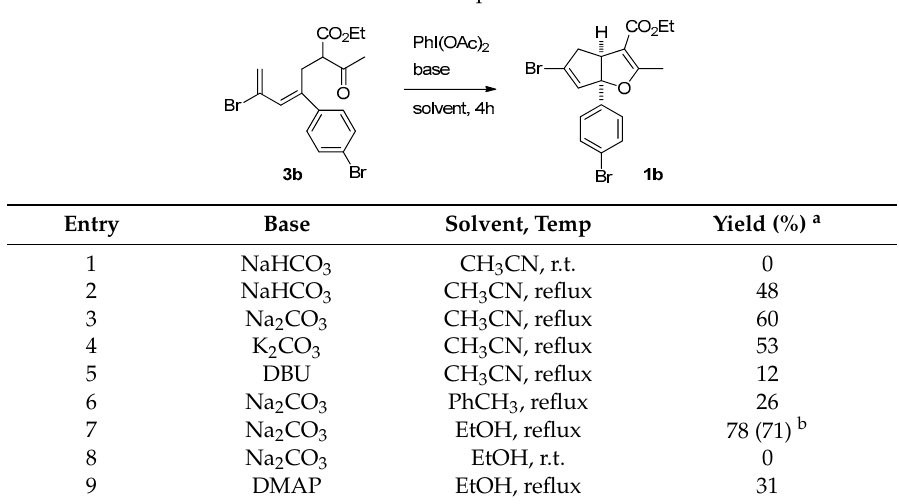
Table 2. Reaction Optimizations a .